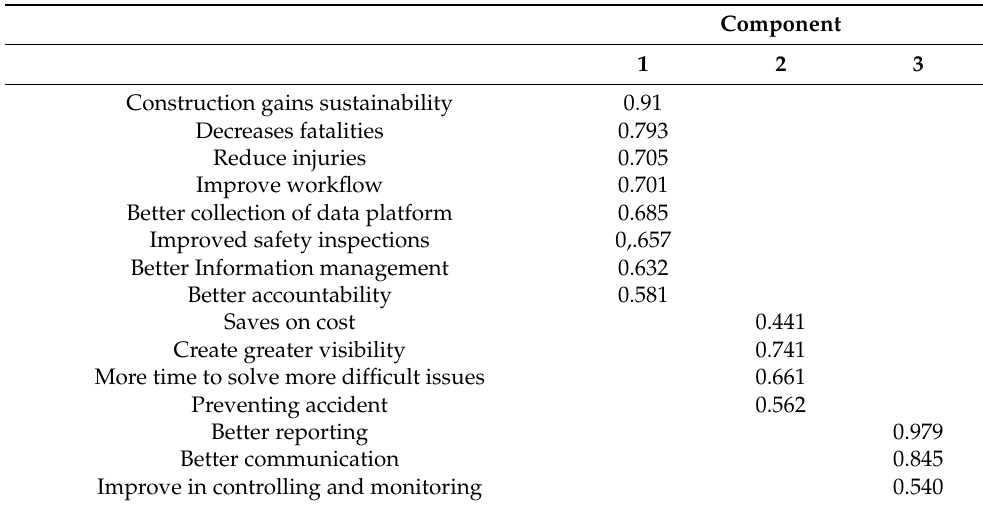
Figure 1. Scree plot for Opportunities. Table 5. Pattern Matrix.